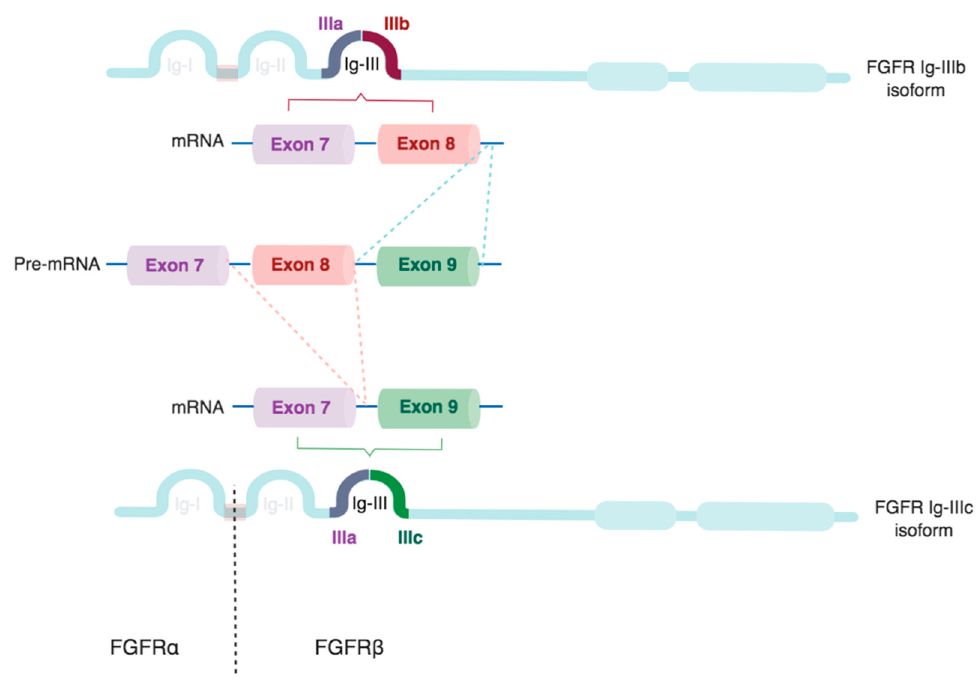
Figure 2. Schematic representation of FGFR splice isoforms. The Ig-III domain of FGFR1–3 is encoded by exons 7–9. Exon 7 encodes Ig-IIIa, which consists of the N-terminal half of the Ig-III loop. The C-terminal half is formed by the IIIb or IIIc sequence, which is generated by the selective inclusion of exons 8 or 9, respectively. Truncation of the Ig-I loop creates FGFR β isoforms (dotted line), while the full-length receptor is termed FGFR α . Image created with biorender.com.